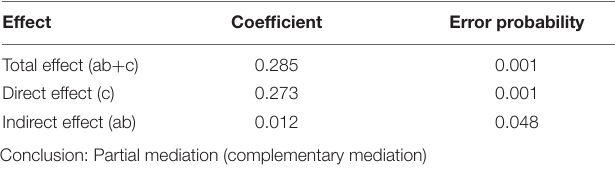
TABLE 8 | Effects of experiential value on inter-customer helping